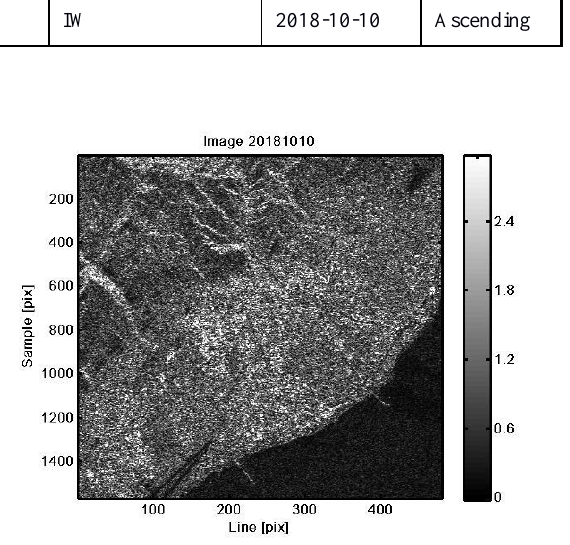
Figure 4. Co-registered image processed in SARPROZ in